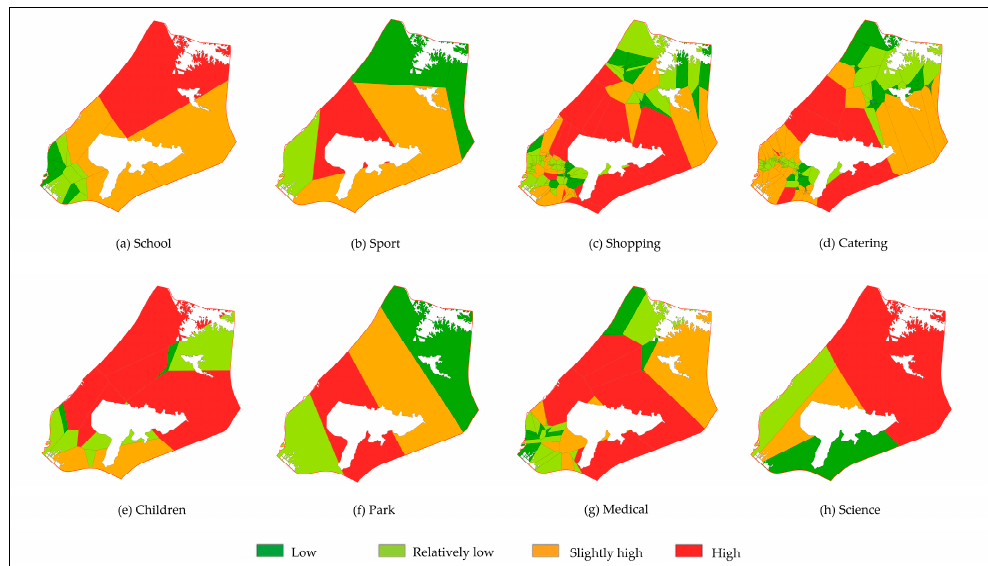
Figure 8. Carrying capacities of the public service facilities in the Chenglingji new port area.